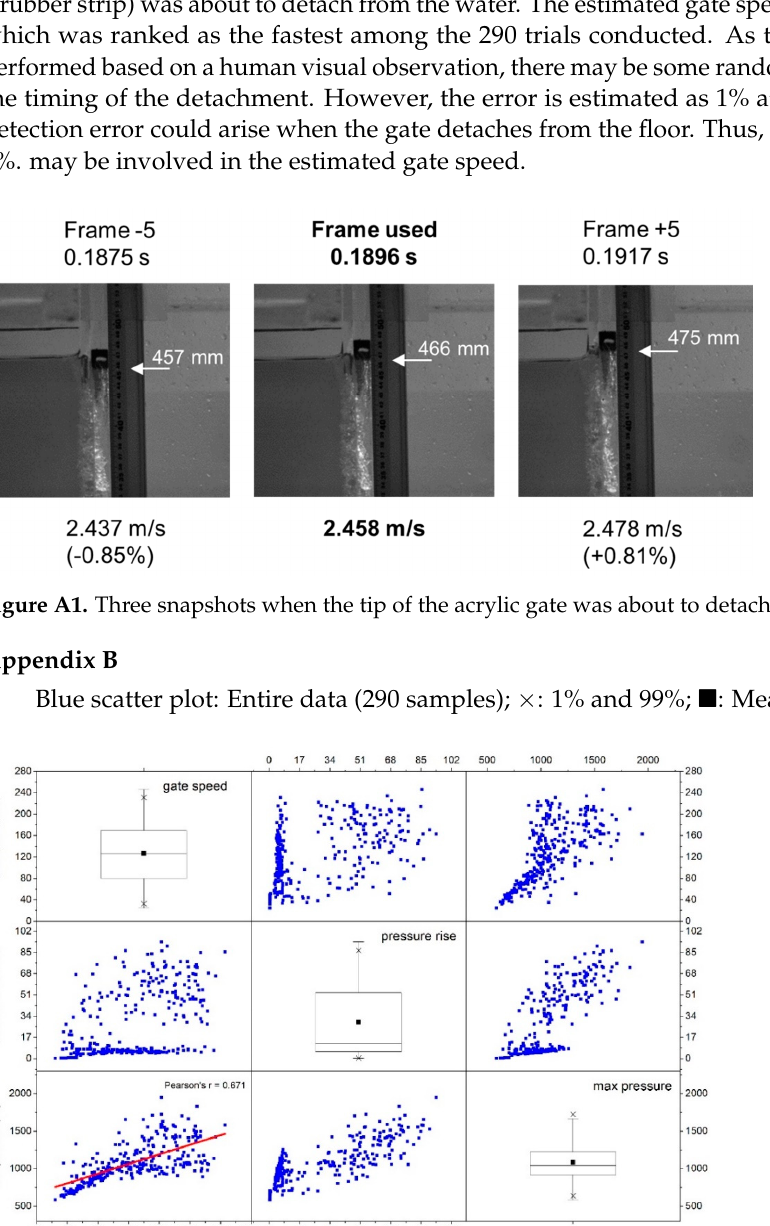
Figure A2. The matrix presenting the relationship between maximum pressure, pressure rise rate, and gate speed at Ch2.